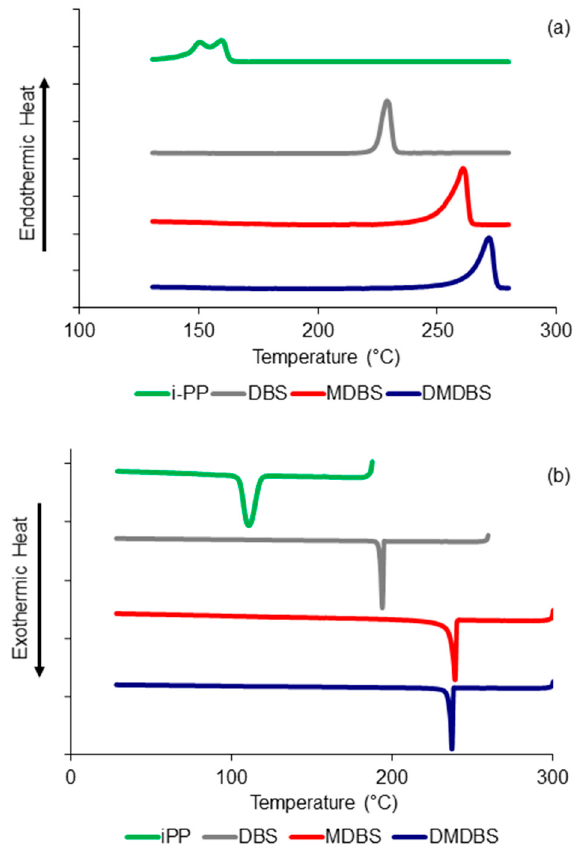
Figure 2. Thermal properties of the studied materials: ( a ) melting points and ( b ) crystallization temperatures of the iPP wax and nucleating agents (heat and cooling rates of 10 °C/min).